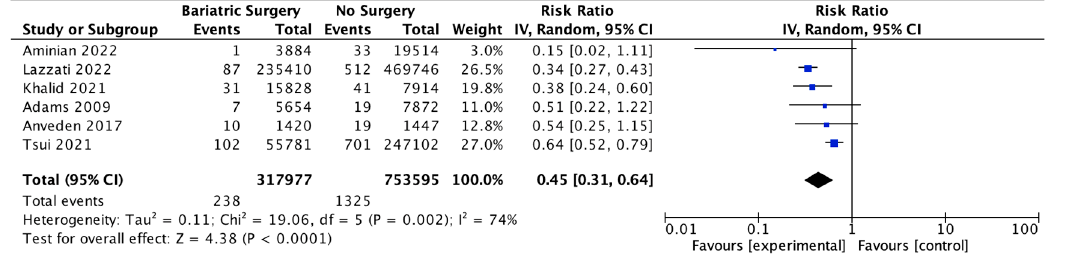
Figure 8. Ovarian cancer incidence [38–40,49,53,55].